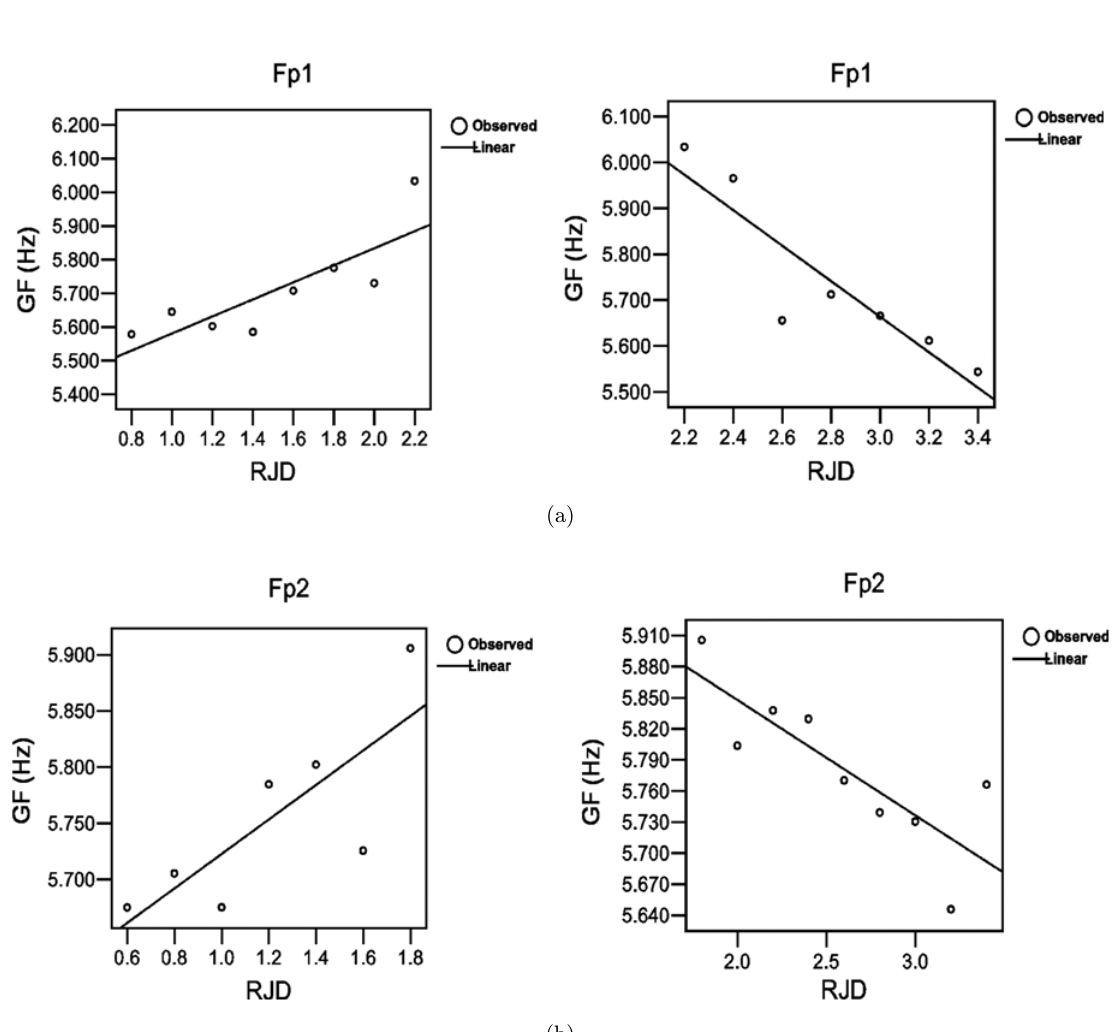
Fig. 4. Fragment curve ¯tting of GF to RJD in di®erent channels of (a) Fp1, (b) Fp2, (c) F3, (d) C3, (e) T5. The x -axis represents the variation of RJD and the y -axis represents